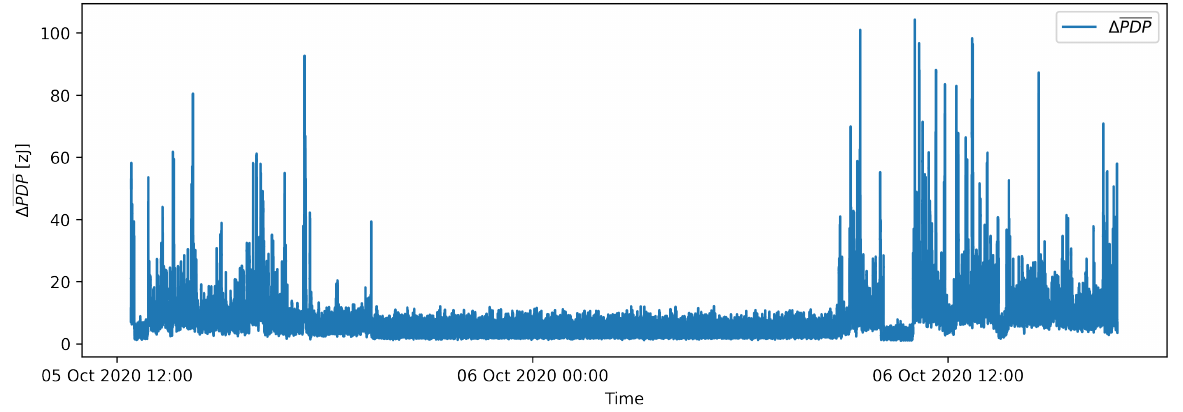
Figure 4. Time series of PDP differences for a 30-h long recording in a pilot environment.